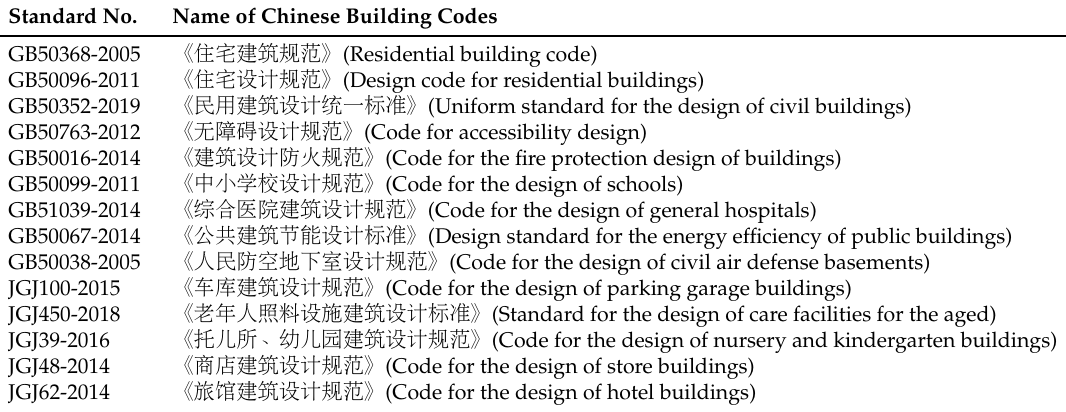
Table 3. Chinese building codes used for dataset